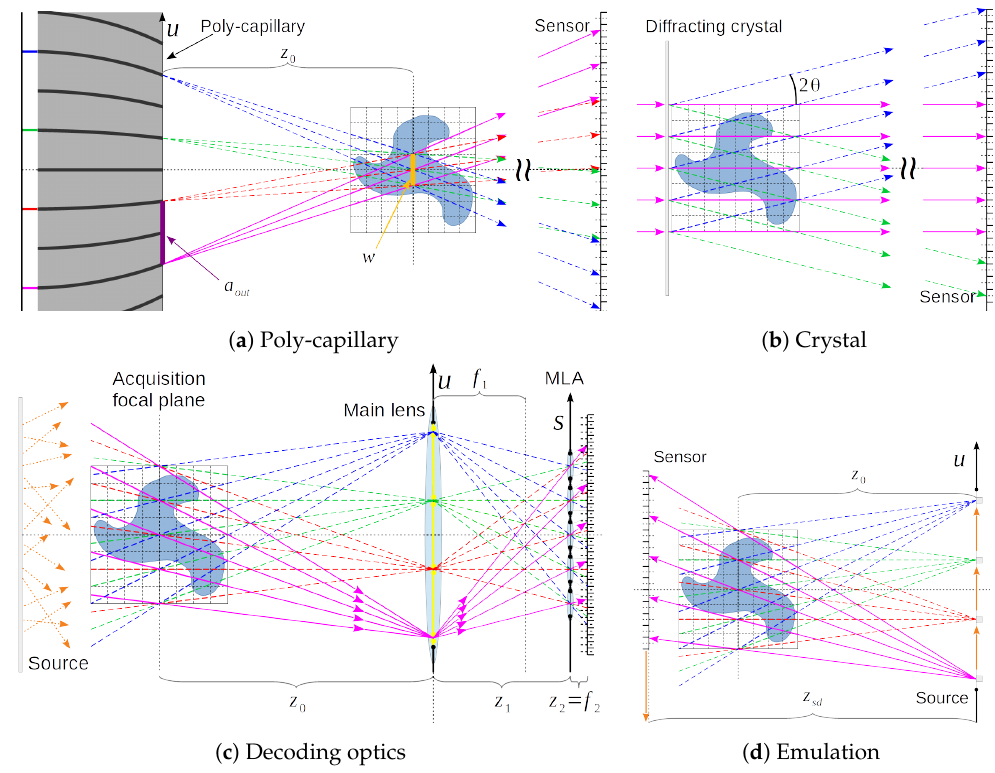
Figure 4. X-ray plenoptic acquisition schemes: ( a ) poly-capillary acquisition scheme; ( b ) diffracting crystal acquisition scheme; ( c ) decoding lenses acquisition scheme (with diffusive source); and, ( d ) tomographic emulation